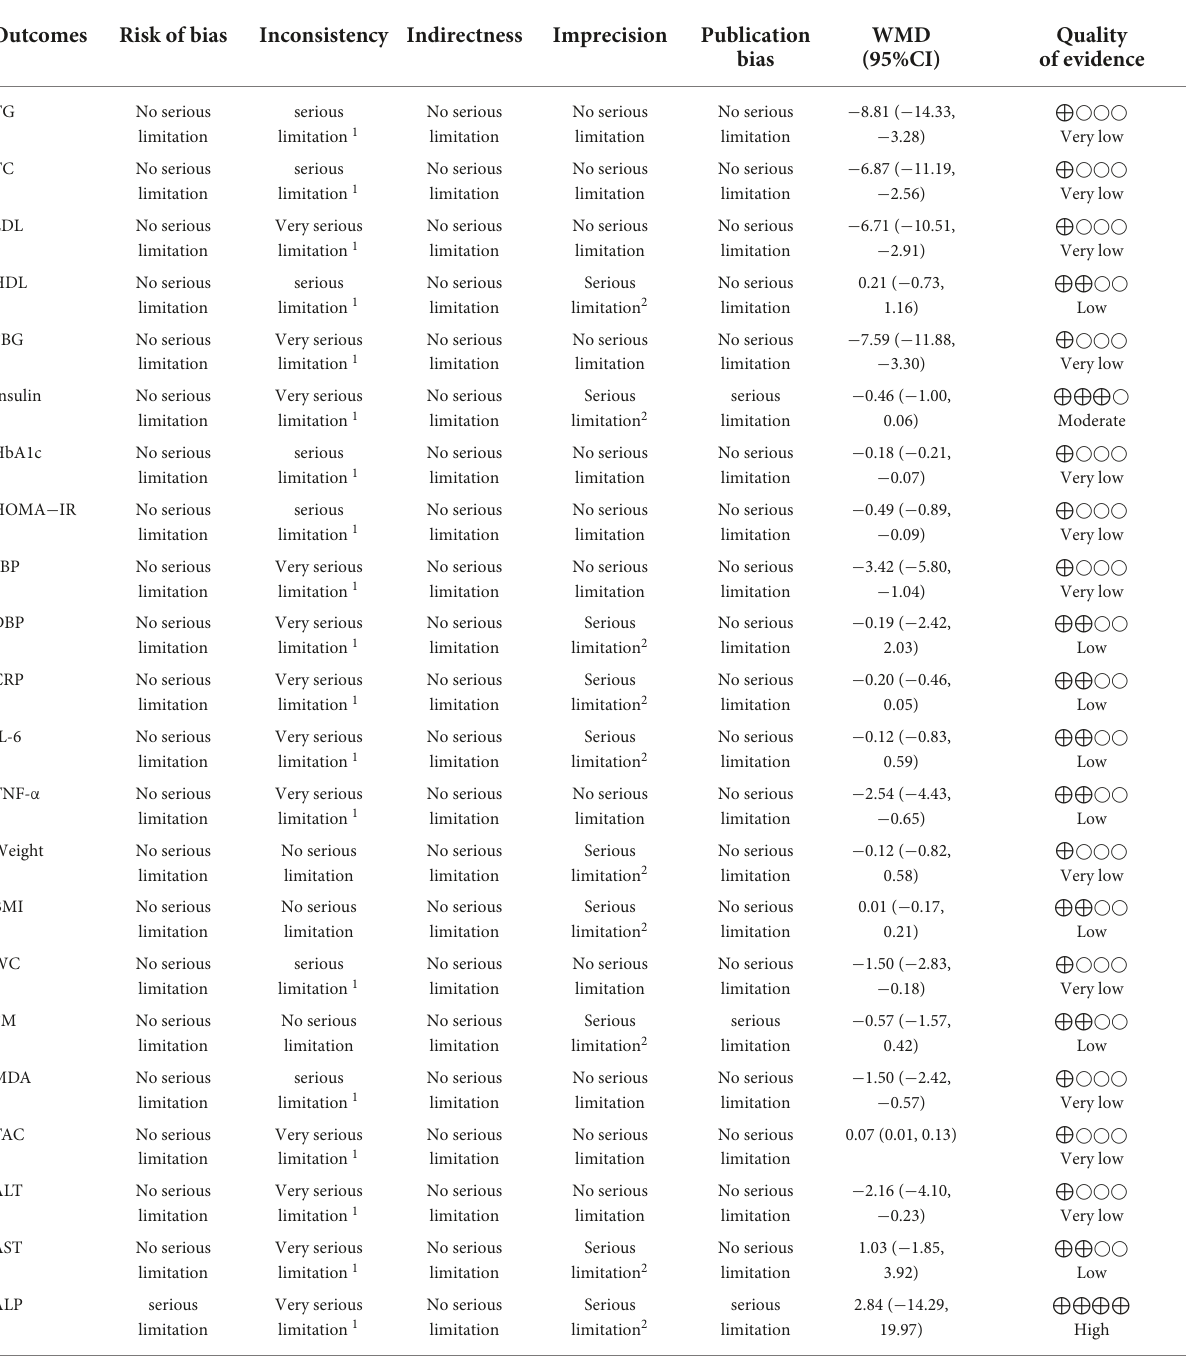
TABLE 4 GRADE profile of saffron on CVD risk factors in